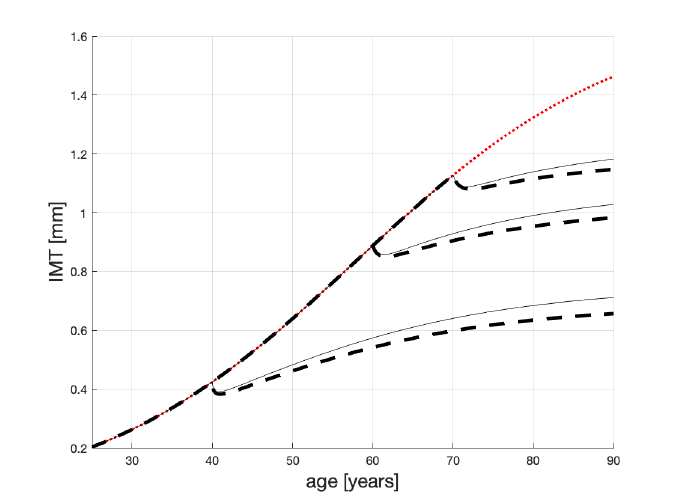
Figure 7. Plausible age profiles for male patients (on dialysis) treated with Atorvastatin: 80 mg/d—dashed line; 40 mg/d—solid